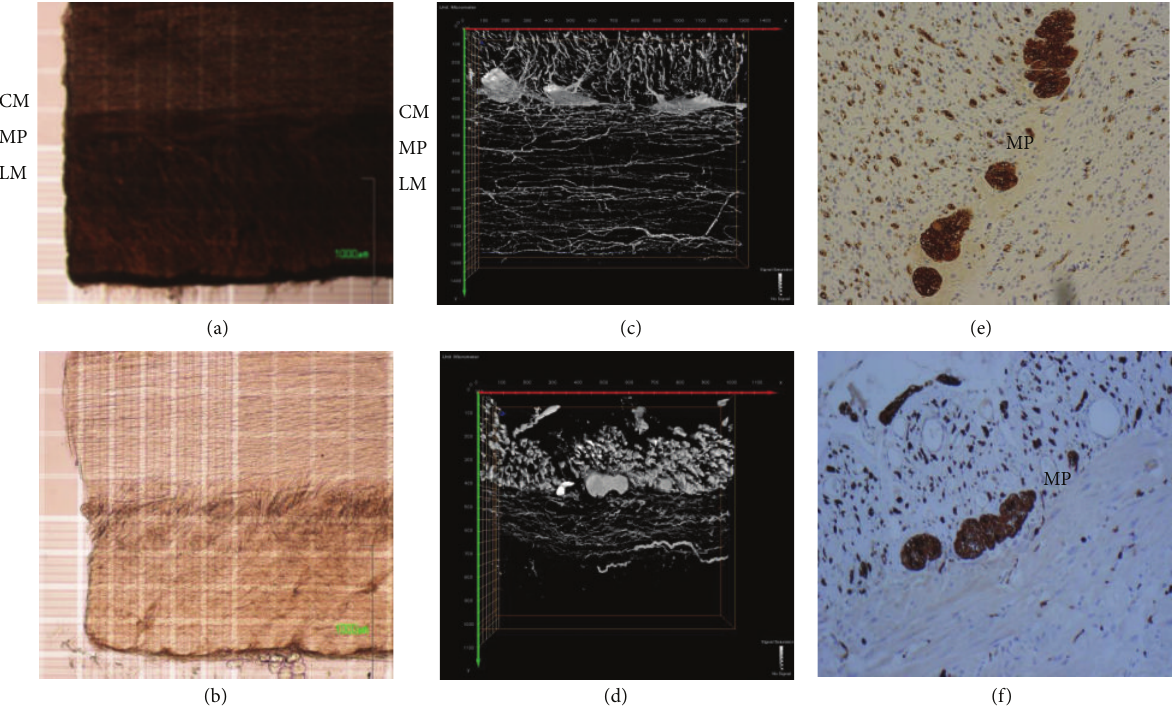
Figure 5: PGP9.5 staining of the myenteric plexus and nerve fibers in the donor and recipient intestinal tissues from a MMIHS patient that received intestinal transplantation. (a) Intestinal tissues in PBS. (b) Optically cleared intestinal tissues. ((c) and (d)) The permeabilized donor (c) and recipient (d) intestinal tissues were stained with PGP9.5 prior to FocusClear treatment. ((e) and (f)) PGP9.5 immunohistochemical studies of the intestinal tissues ((e), donor; (f), recipient, 100x). CM: circular muscle layer; MP: myenteric plexus; LM: longitudinal muscle layer. Bar: 100 𝜇